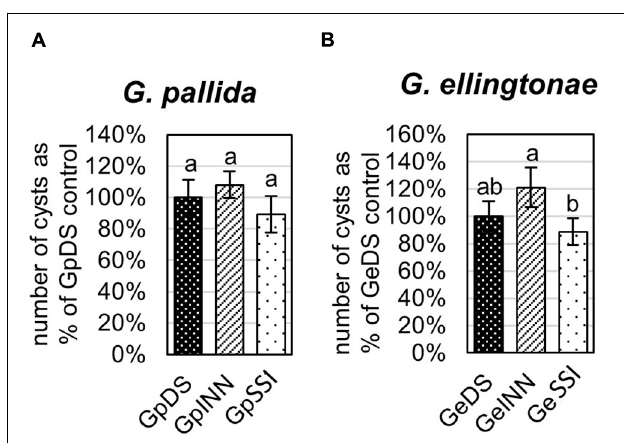
FIGURE 2 | Reproduction rate of (A) Globodera pallida or (B) Globodera ellingtonae on a susceptible potato cv. Desirée (DS) was measured as the percentage of value for a control DS hatching treatment. The number of cysts/plant was counted 8 weeks postinfection with J2s hatched in root exudates from susceptible potato control (cv. Desirée - DS), resistant potato (cv. Innovator - INN), or immune plant ( S. sisymbriifolium - SSI). Each value represents the mean ± SE from bulking samples of three independent experiments. Means having the same letter designation are not significantly different as determined using ANOVA followed by Tukey’s HSD test at p < 0.05.